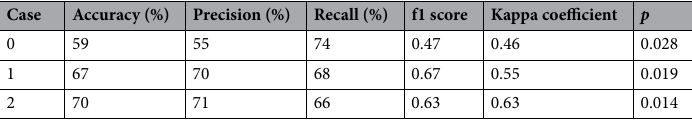
Table 8. 1-D CNN model results.